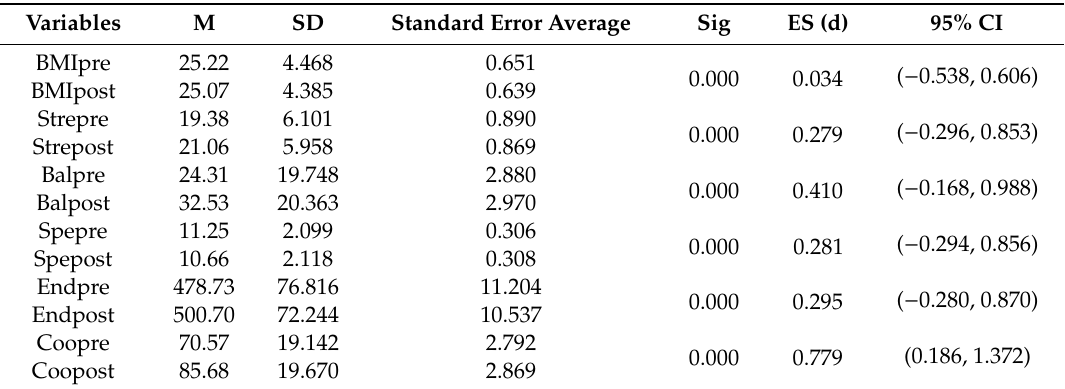
Table 2. Results for pre- and post-intervention tests.